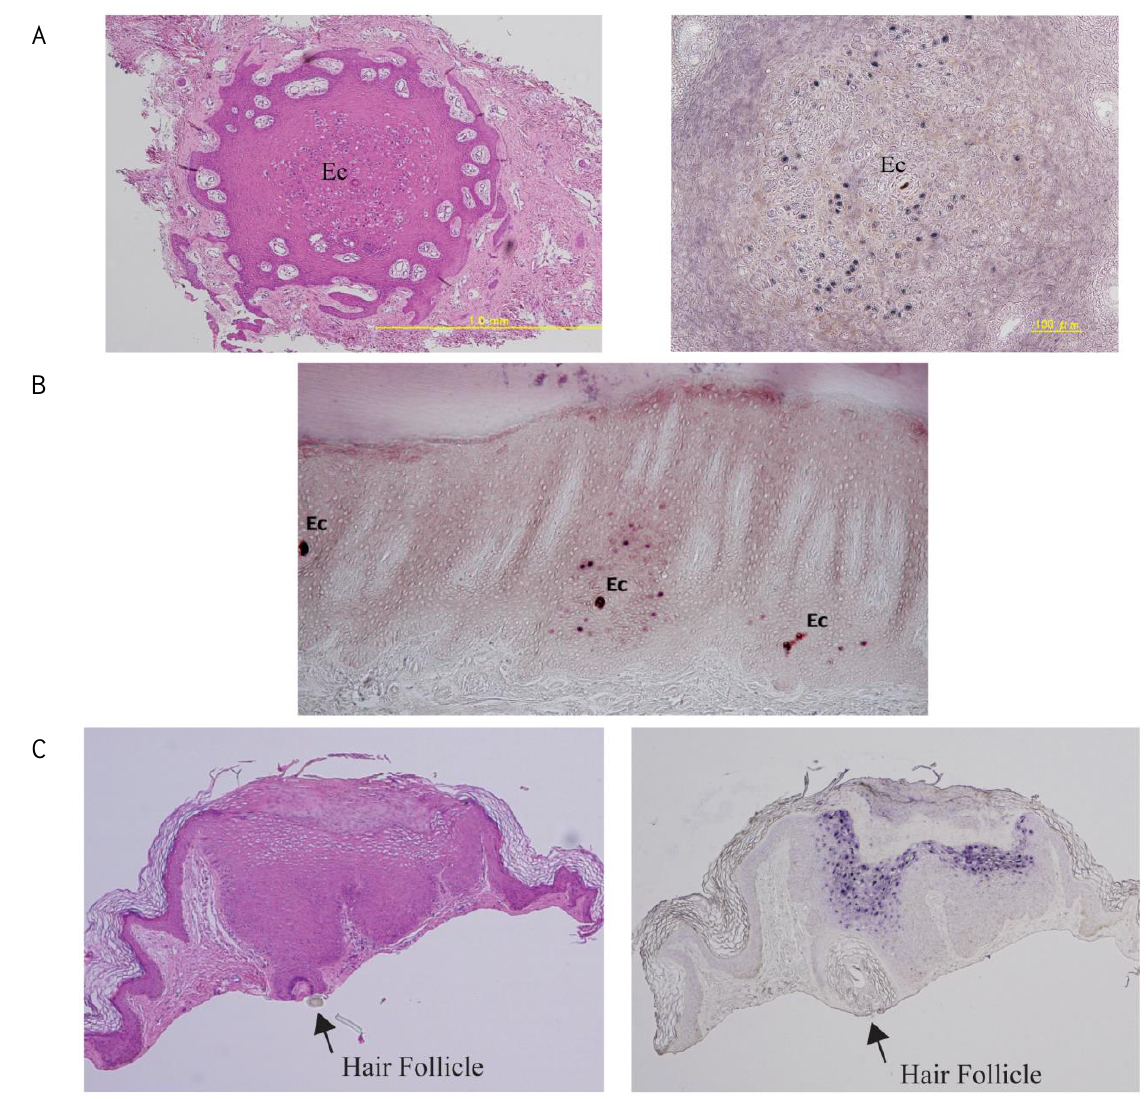
Figure 7. Examples for HPV targeting cutaneous appendages. ( A ) Haemotoxylin & eosin stain ( left ) of a horizontal section of a tiny wart. An eccrine (Ec)-centered distribution of histological changes is observed. HPV1 DNAs are identified within the pathology changes following DNA in situ hybridization ( right ); ( B ) HPV63 DNA is identified in resident keratinocytes in the vicinity of eccrine ducts (Ec) in a ridge of the plantar skin following DNA in situ hybridization; ( C ) HPV6/11 histopathological changes are identified in the resident keratinocytes in and around the hair follicle (arrow) by haemotoxylin & eosin staining ( left ) and DNA in situ hybridization ( right ).